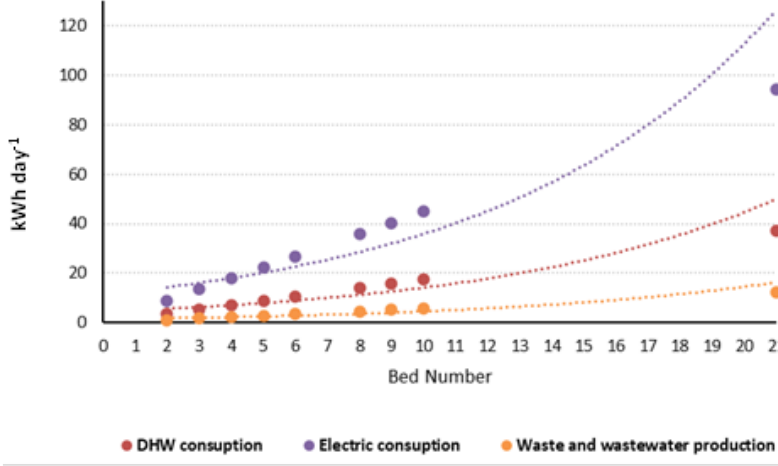
Figure 3. Consumption and generation of waste by type of rural house.